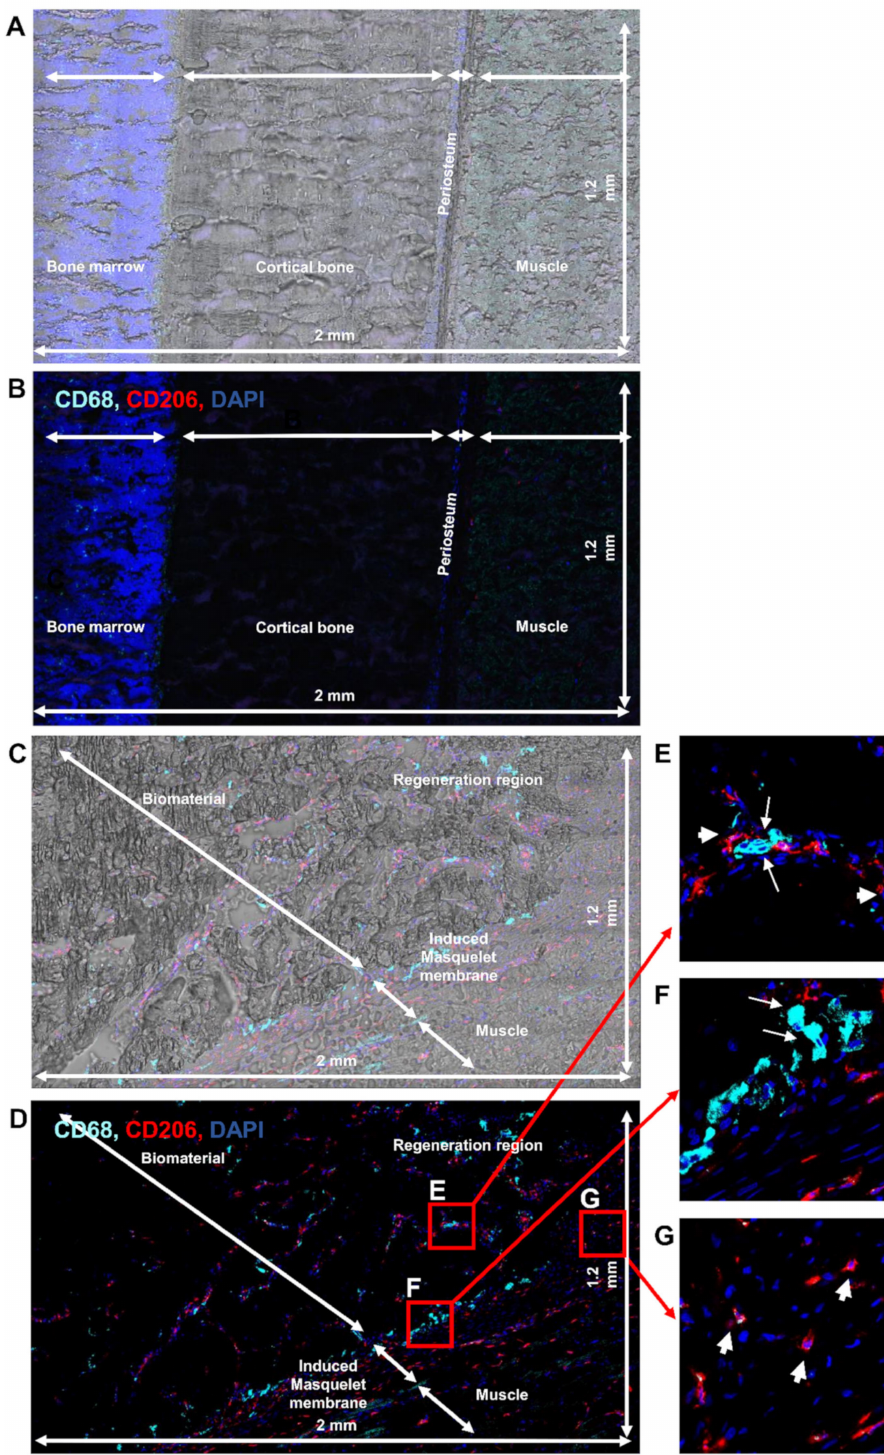
Figure 3. Identification of M1-like and M2-like macrophages in the rat femurs: ( A,B ) immuno- labeling with anti-CD68 and CD206 antibodies of the non-operated; and ( C – G ) operated femurs; bright-field image together with immunolabeling of the non-operated ( A ) and operated ( C ) femurs; ( E – G ) expanded view: high magnification image of the area within the red rectangle in image C; anti-CD68 (Alexa488, turquoise fluorescence), labeling the M1 and M2 macrophages; anti-CD206 (Alexa568, red fluorescence) labeling the M2 macrophages and satellite cells; nuclear staining with DAPI (blue fluorescence); thin arrow: M1-like macrophages; thick arrow: M2-like